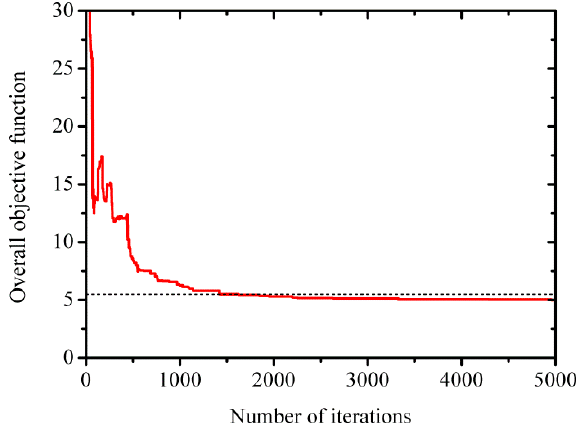
Figure 7. Evolution of the overall objective function (Equation (7)) with number of iterations. The dashed line indicates the threshold (5.5) used to stop the iteration.